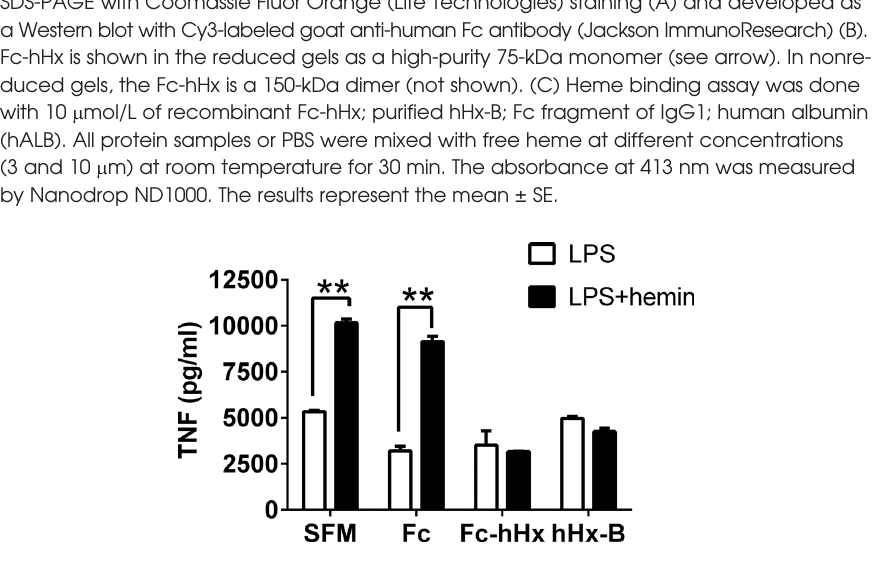
Figure 4. Recombinant Fc-hHx inhibits TNF production synergistically induced by LPS and hemin. Mouse BMDMs were incubated with LPS (2 ng/mL) only or with hemin (1 μ mol/L) in serum-free medium (SFM) for 9 h in the absence or presence of 1.67 μ mol/L of one of the following proteins: Fc fragment of IgG1; Fc-hHx; hHx-B. TNF levels were measured in the super- natants of the culture. The results represent mean ± SE and are representative of four inde- pendent experiments. ** P < 0.01, compared between cells treated with and without